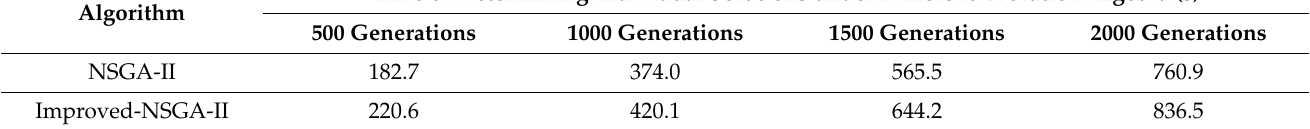
Table 6. Comparison of the two algorithms for time of determining individual solutions under different four evolution